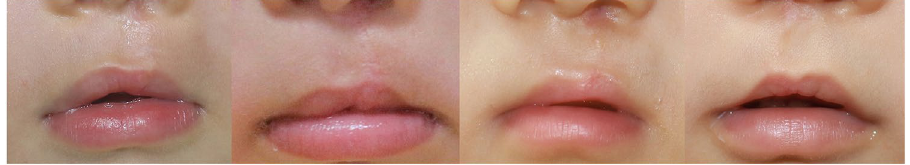
Figure 1. Babies from the study group (silicone gel group) showing similar quality scars to the control group.